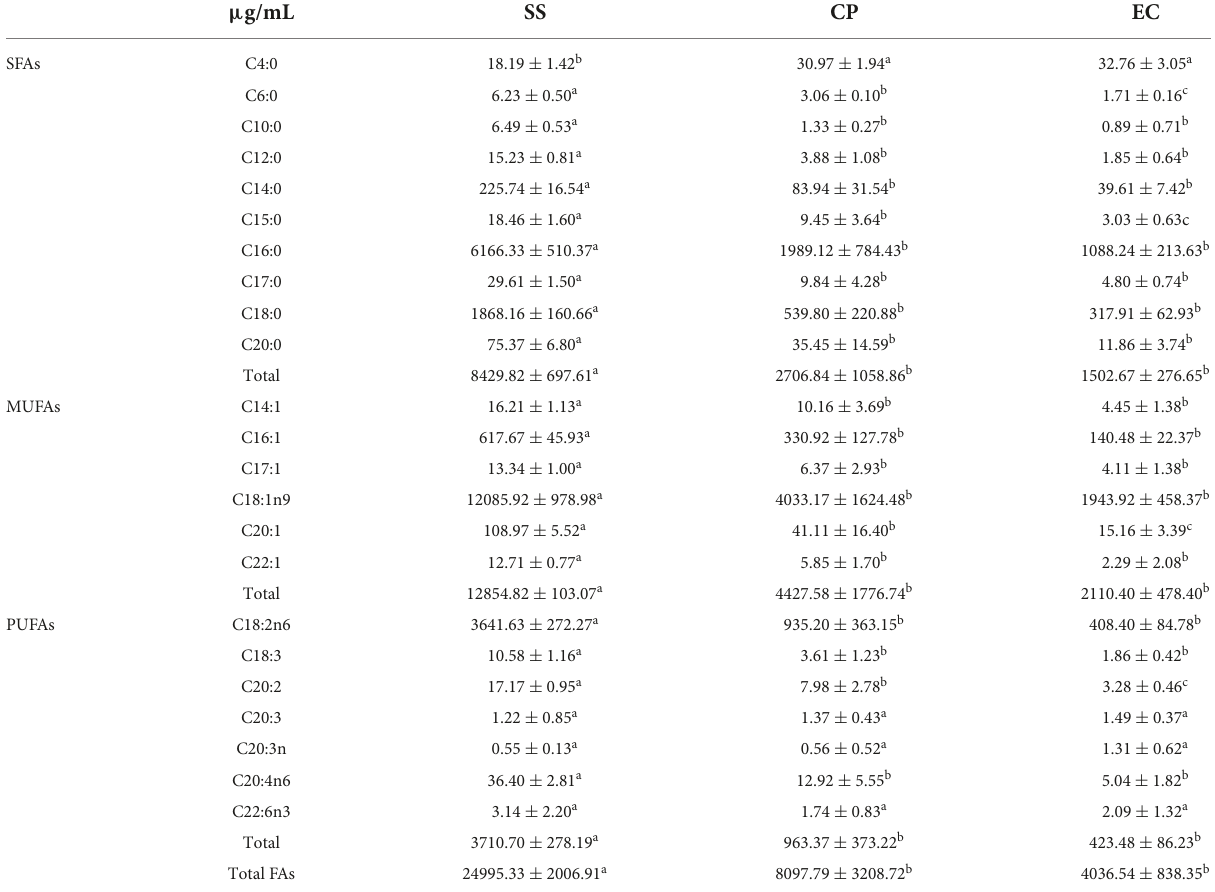
TABLE 1 Effect of cooking mode on fatty acids of Clitocybe squamulose chicken soup.